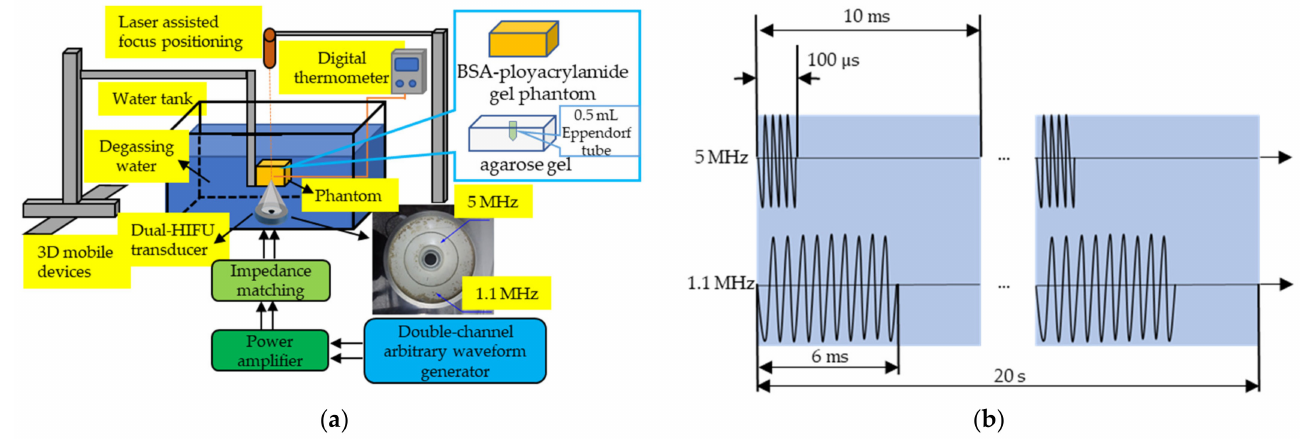
Figure 1. Experimental setup ( a ) and excitation waveform ( b ). Table 1. Acoustic intensity of 1.1 MHz high-intensity focused ultrasound (HIFU) at different electric powers. P * (W)